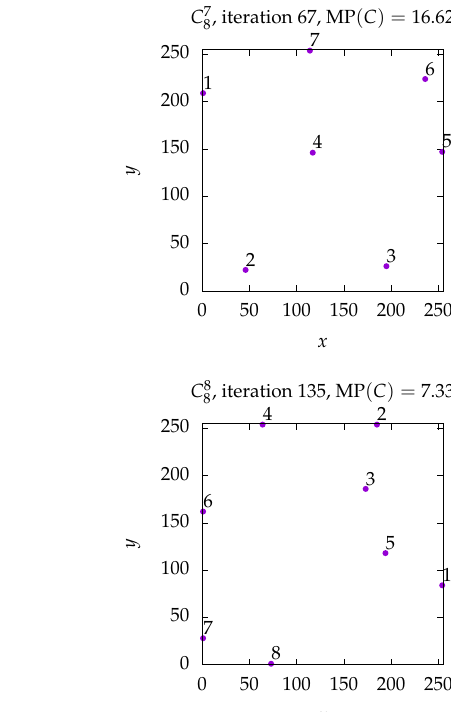
and C 6 without the 5 9